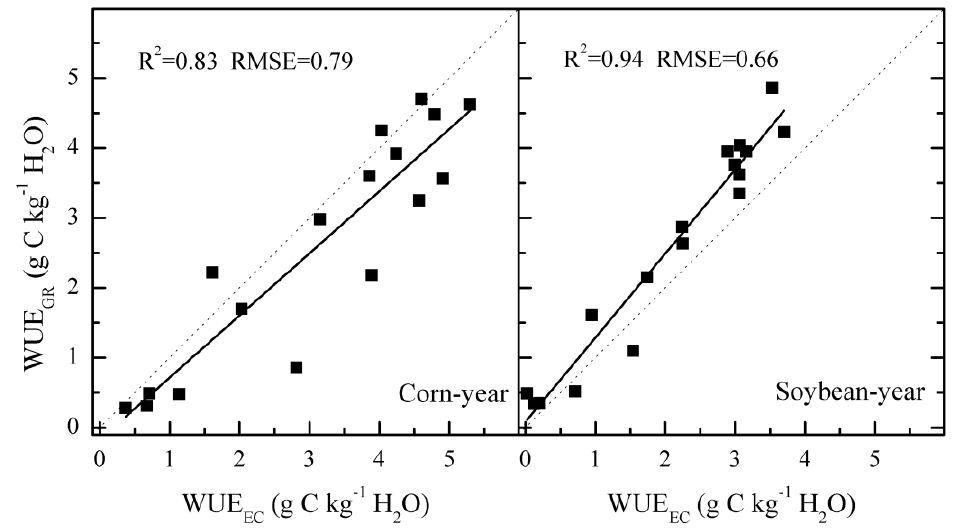
Figure 6. A scatterplot comparison between ecosystem WUE from flux tower measurements (WUE EC ) and estimates based on MODIS EVI data (WUE GR ) at the flux tower site US-Bo1 during the growing season of 2005 (corn) and 2006